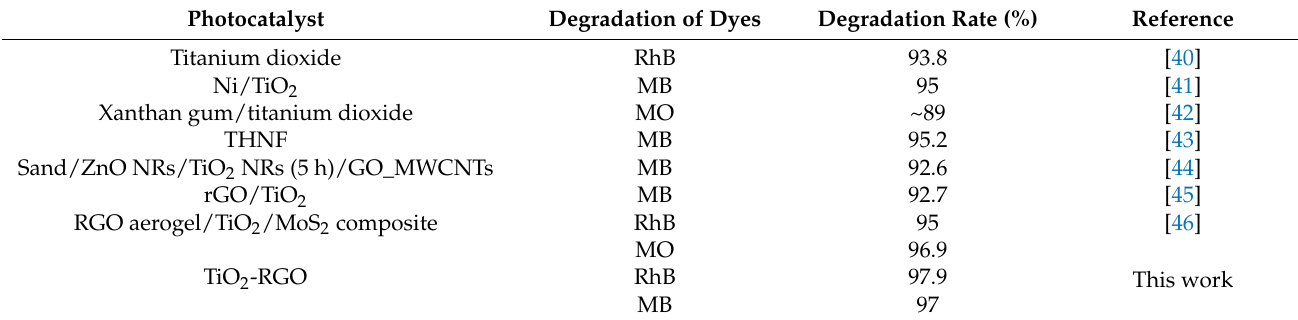
Table 5. Comparison of dye degradation effects among various photocatalysts.